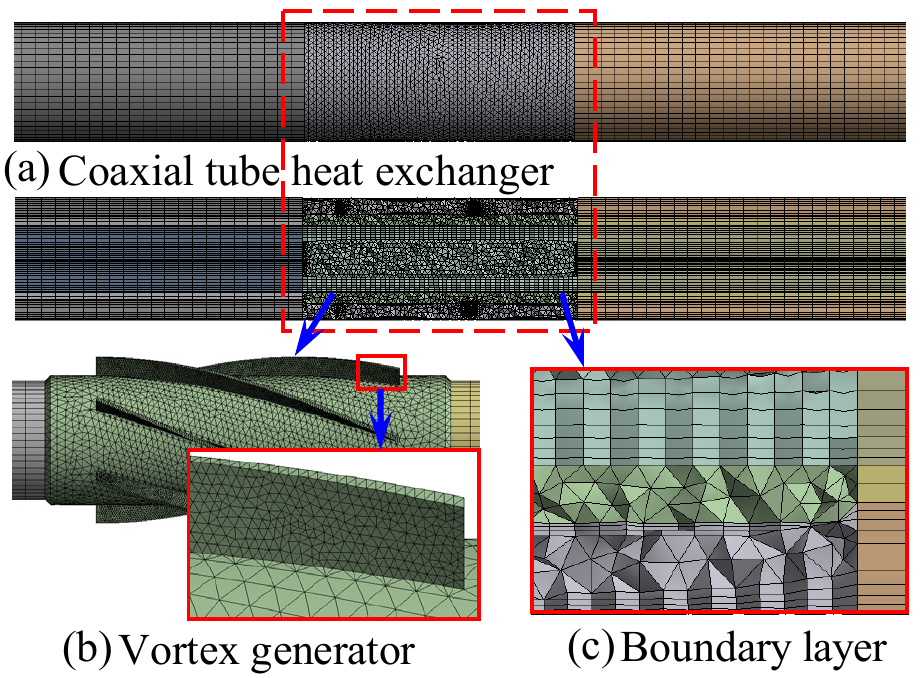
Figure 3. Mesh generation of coaxial borehole heat exchangers. Table 3. Mesh metrics.